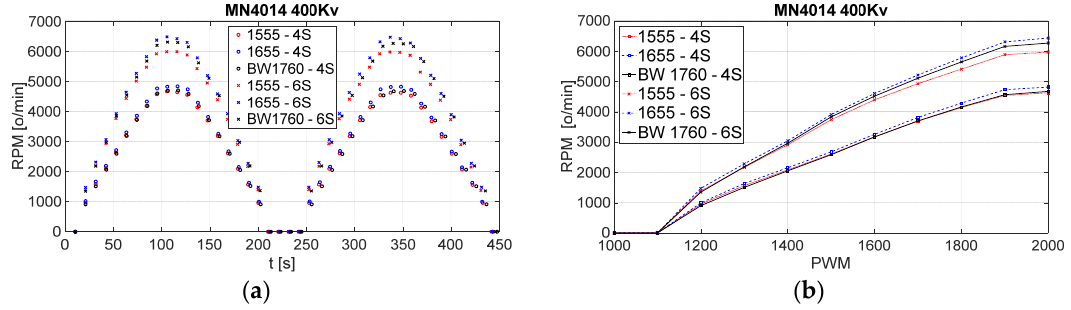
Figure 9. Rotor RPM for setup with MN 4014 BLDC motor: ( a ) raw measurement; ( b ) RPM static maps.